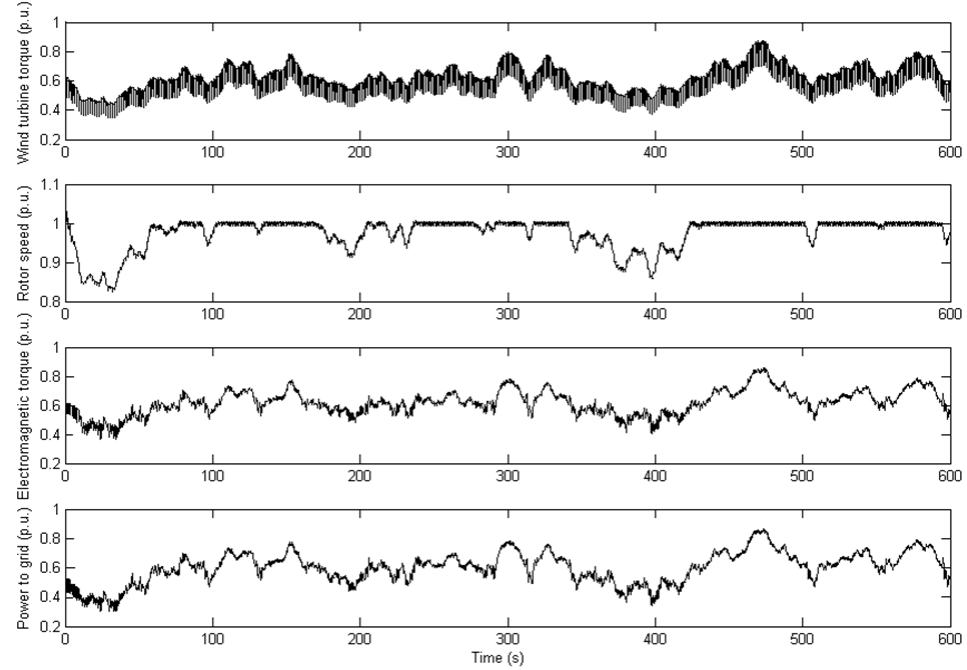
Figure 9. Long-term view of the wind turbine torque, the generator rotational speed, the electromagnetic torque and the active power to the